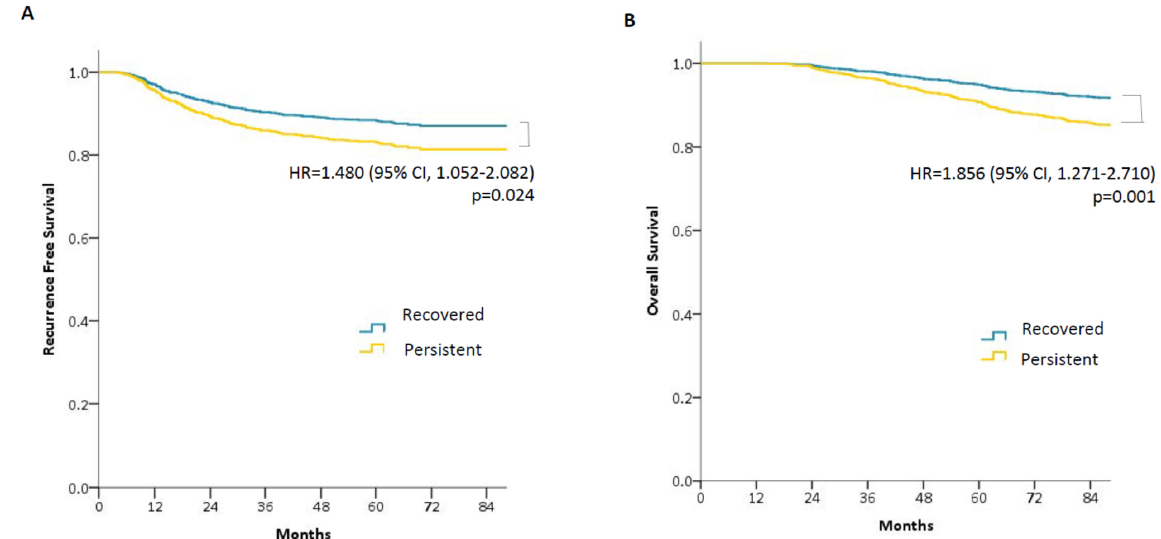
Figure 4. Oncological outcomes according to changes in body composition between preoperative and 2–3-year postoperative status. Recovered to normal body composition (Recovered) vs. persistent sarcopenia (Persistent). Patients with persistent sarcopenia showed both shorter RFS and OS than patients who recovered to normal body composition. ( A ) Recurrence-free survival (RFS); ( B ) Overall survival (OS). HR, hazard ratio; CI, confidence interval.